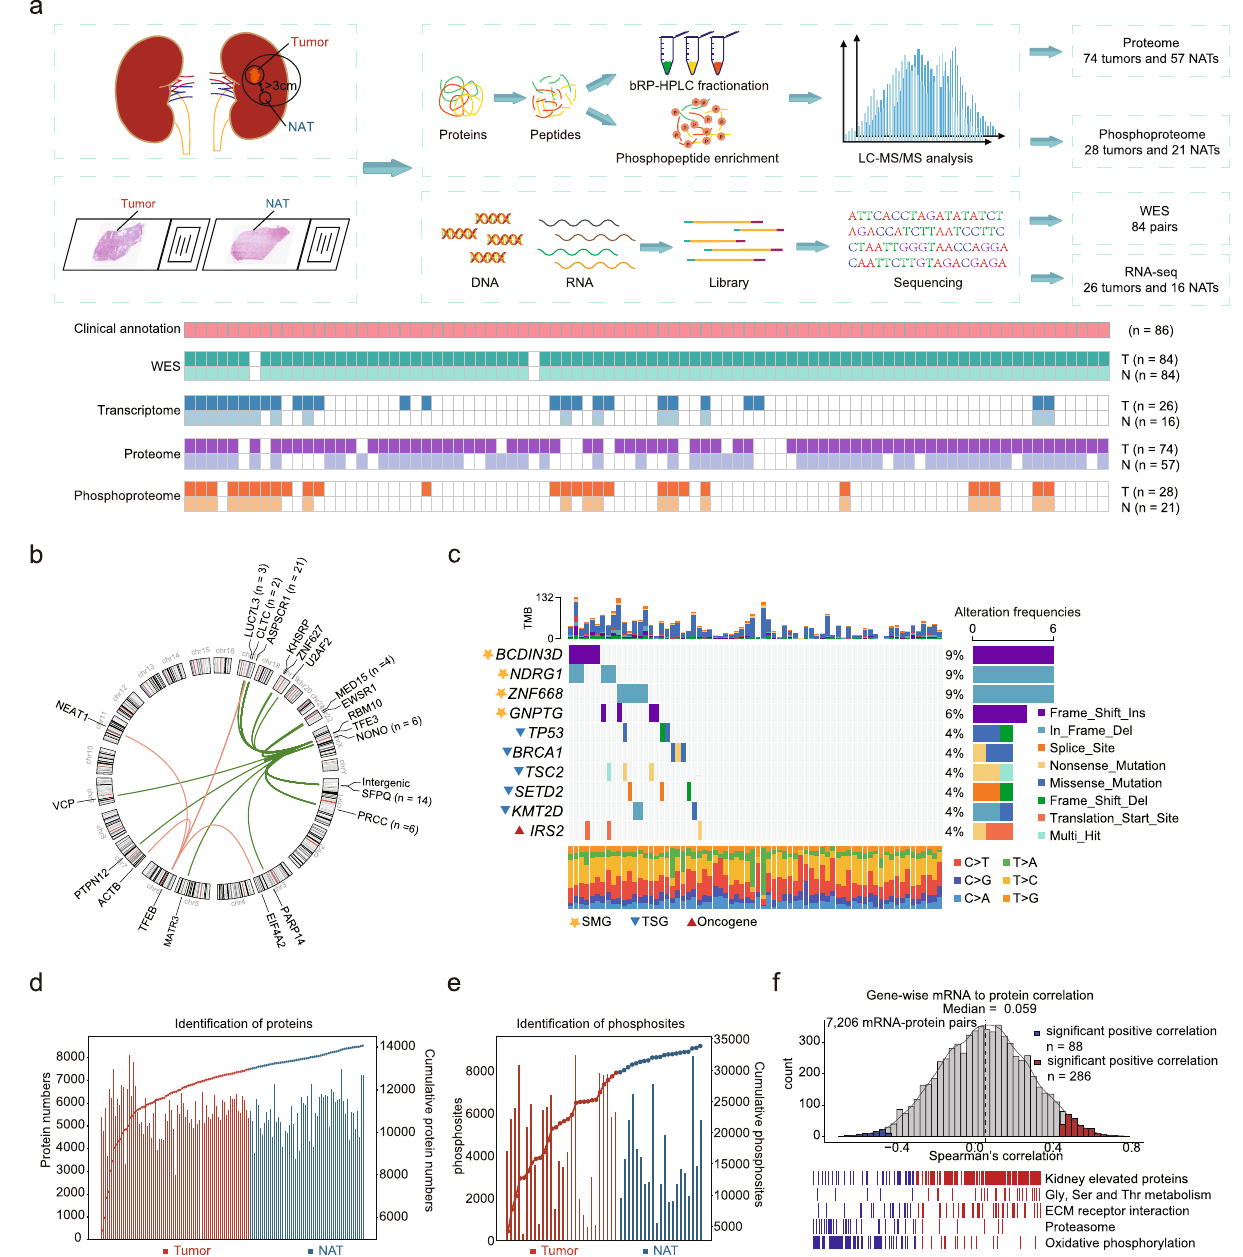
Fig. 1 | Molecular pro fi ling of MiT family tRCC. a Schematic representation of tRCC multiomics analyses, including WES, RNA-seq, proteomics, and phospho- proteomics. b Circos plot showing the TFE3/TFEB gene fusion events. c Genomic pro fi leof70tRCCtumorswithsomaticmutations.SMGs,TSGs,andoncogenesare